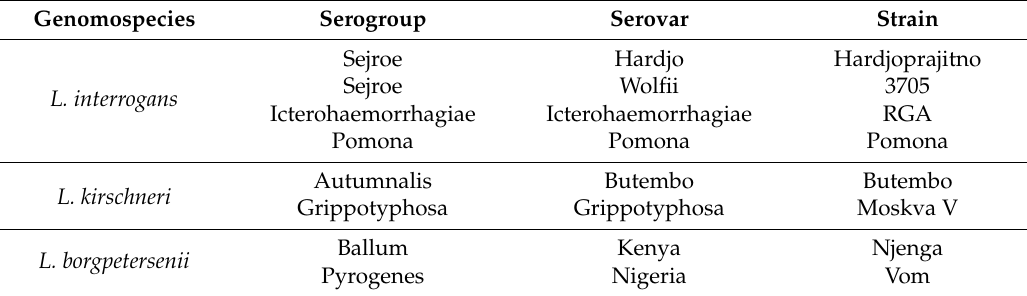
Table 1. Strains of Leptospira spp. used as live antigens in the Microscopic Agglutination Test. Genomospecies Serogroup Serovar